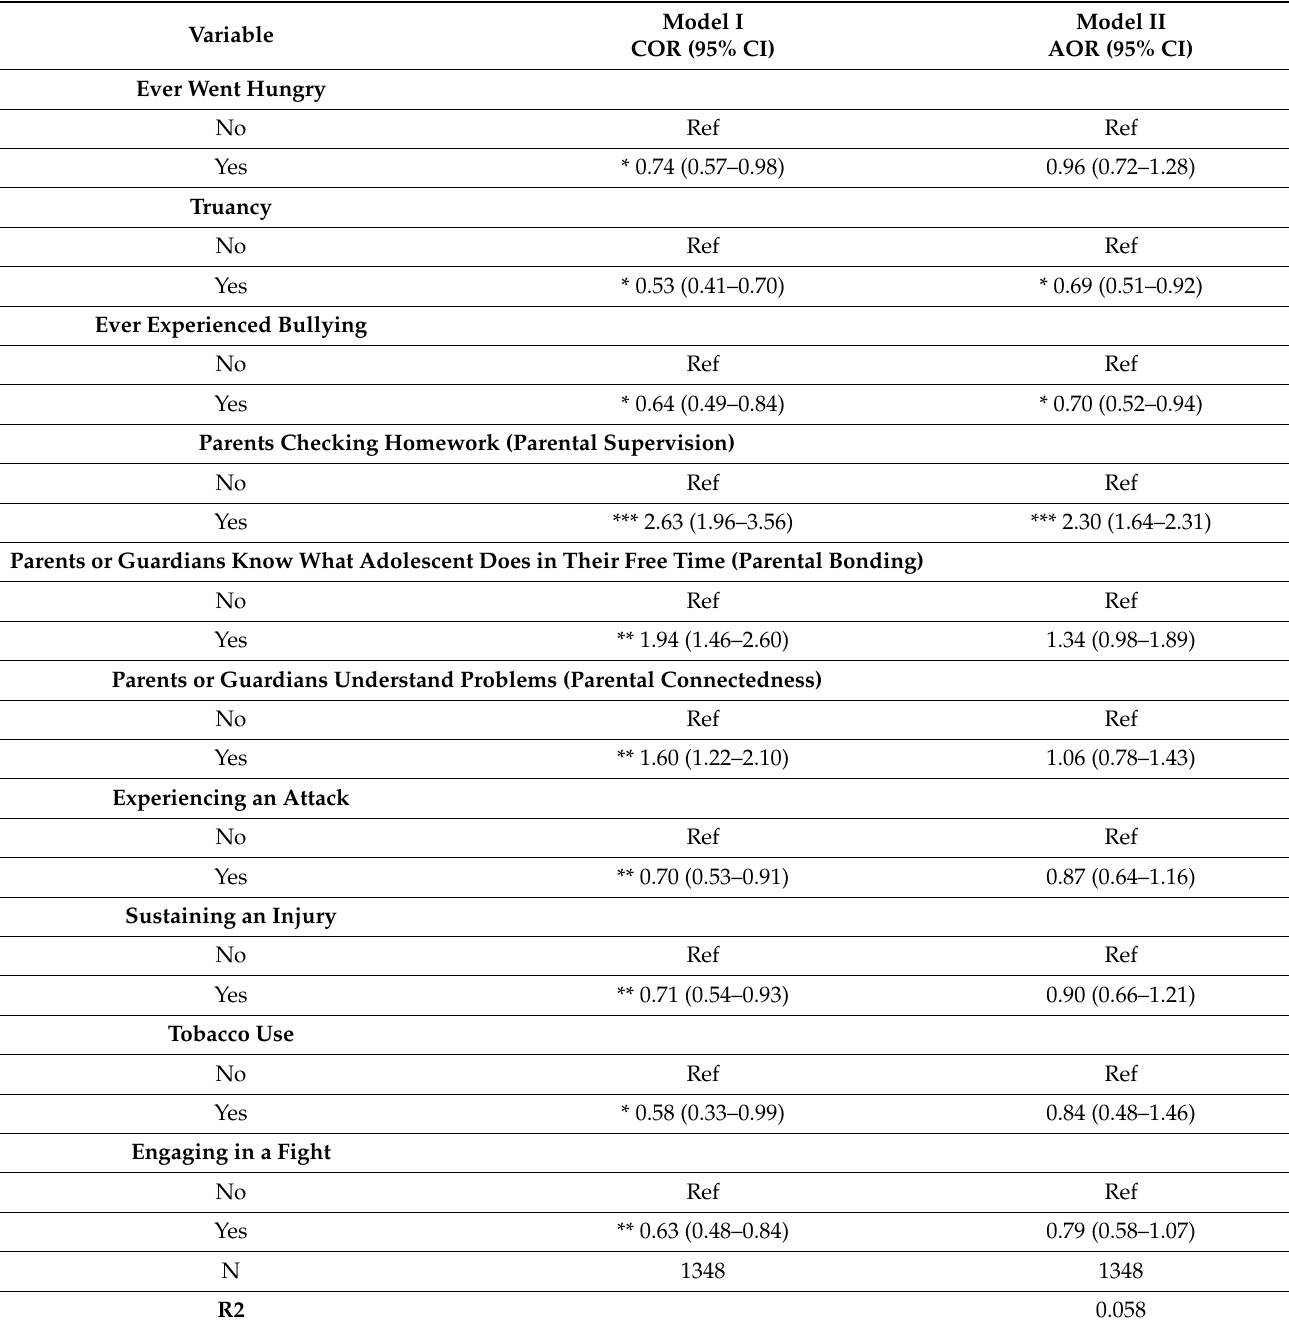
Table 3. Logistic Regression Analysis on the Predictors of Hand Hygiene among In-school Adolescents in Ghana.